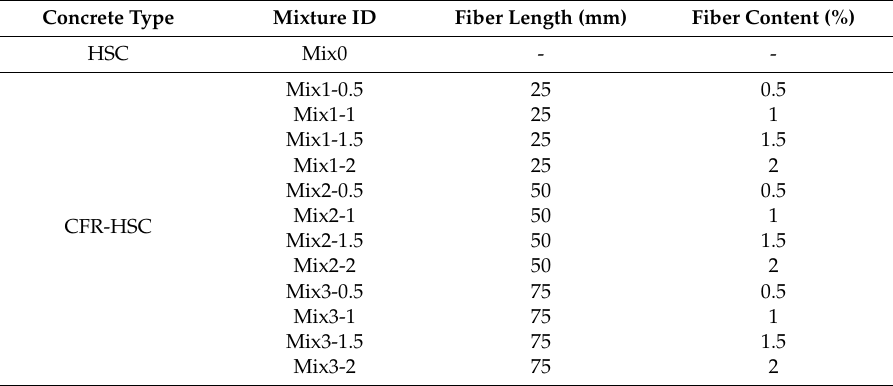
Table 2. Mix proportions of fiber lengths and contents for concrete mixes.